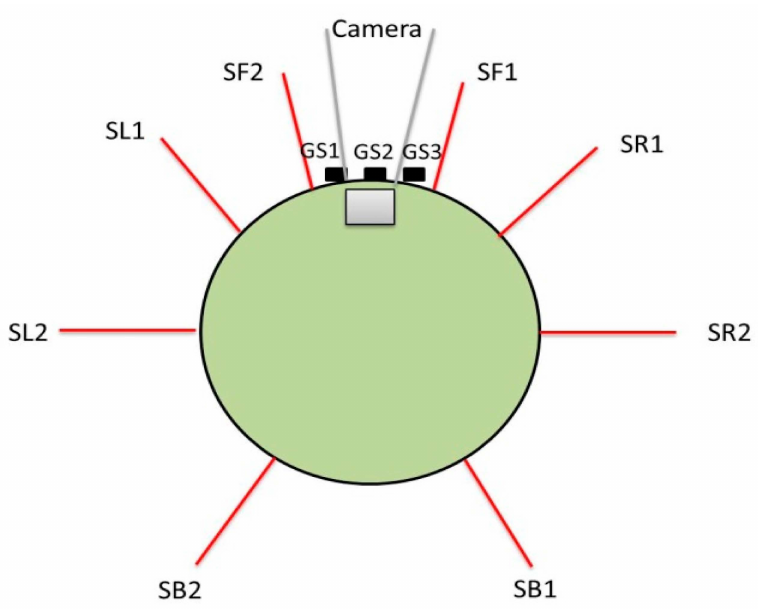
Figure 1. The top view of E-puck robot with various types of